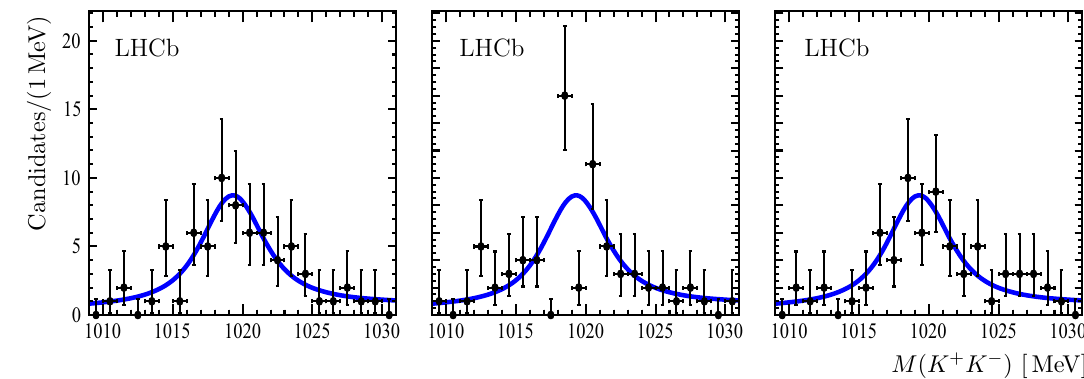
Fig. 2 Result of the 2D fit to the 2 ( K + K − ) invariant mass distribution along with the projections to the K + K − invariant mass axes in the B 0 s signal region